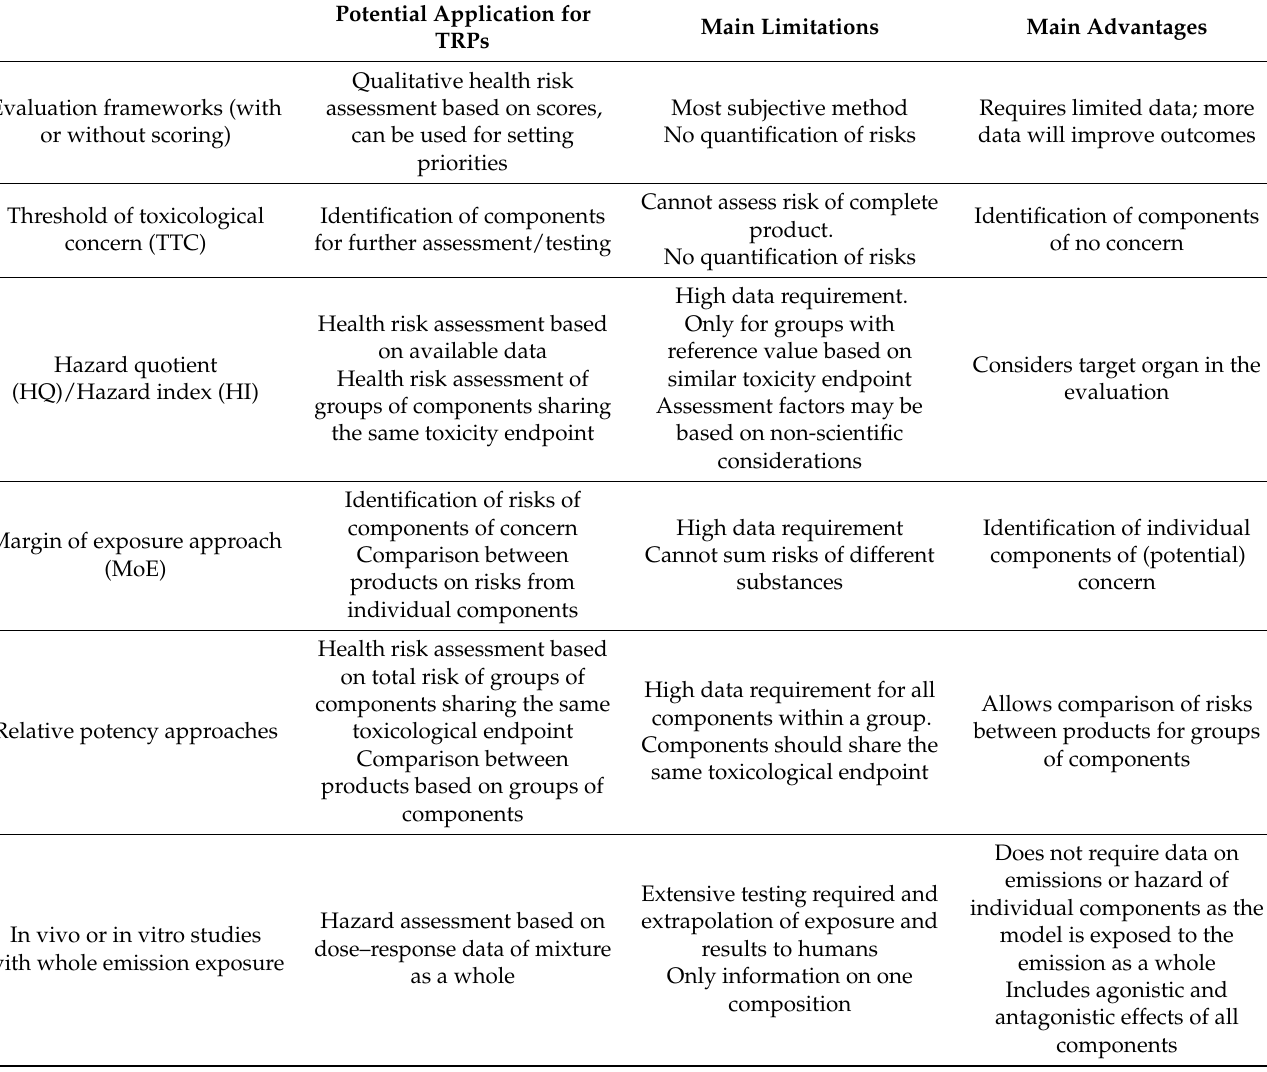
Table 1. Main limitations and advantages of each method for quantifying the health risk of